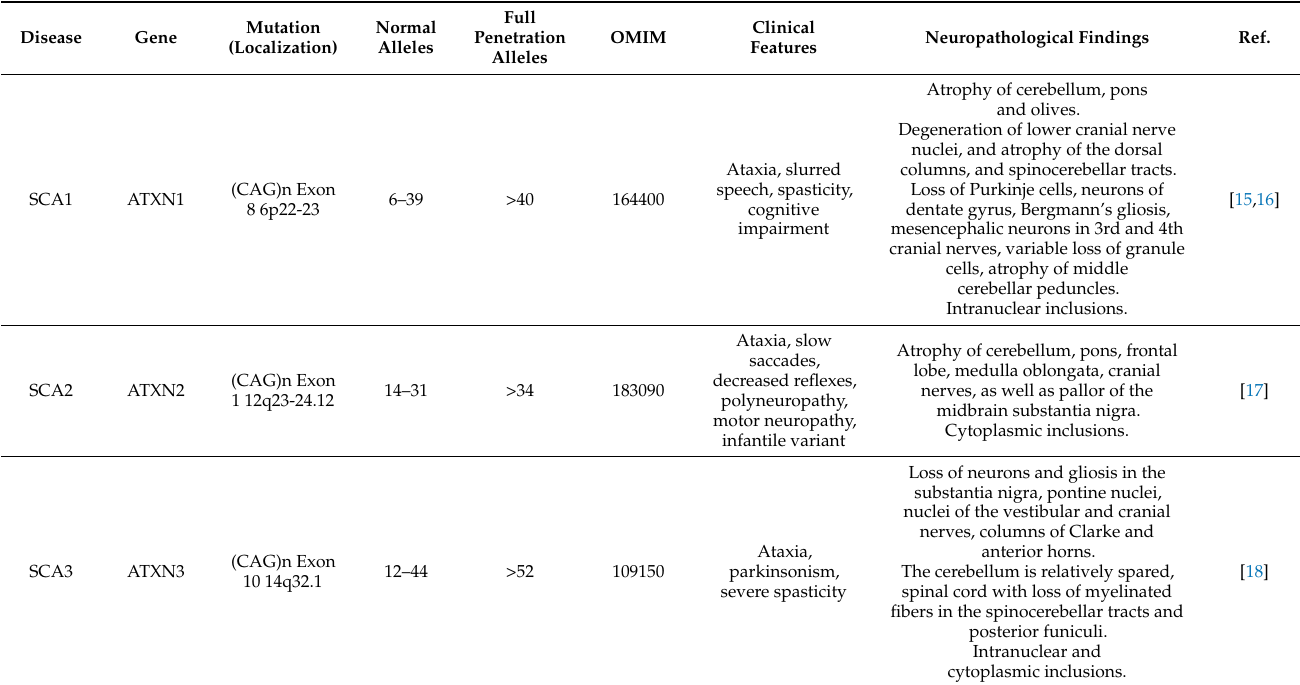
Table 1. Genetic and clinical pathogenesis of polyQ-spinocerebellar ataxias.